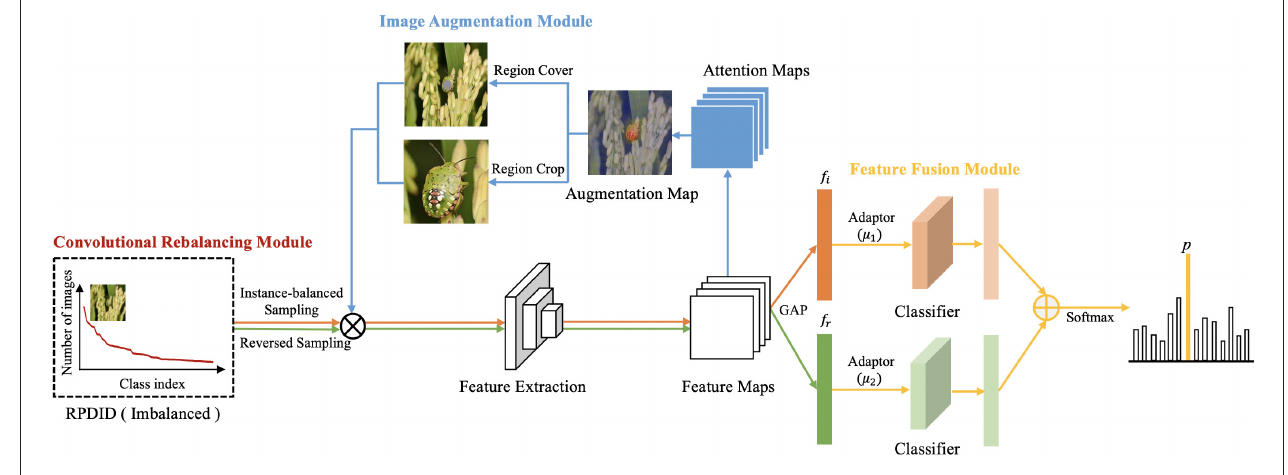
FIGURE 2 | Overview of